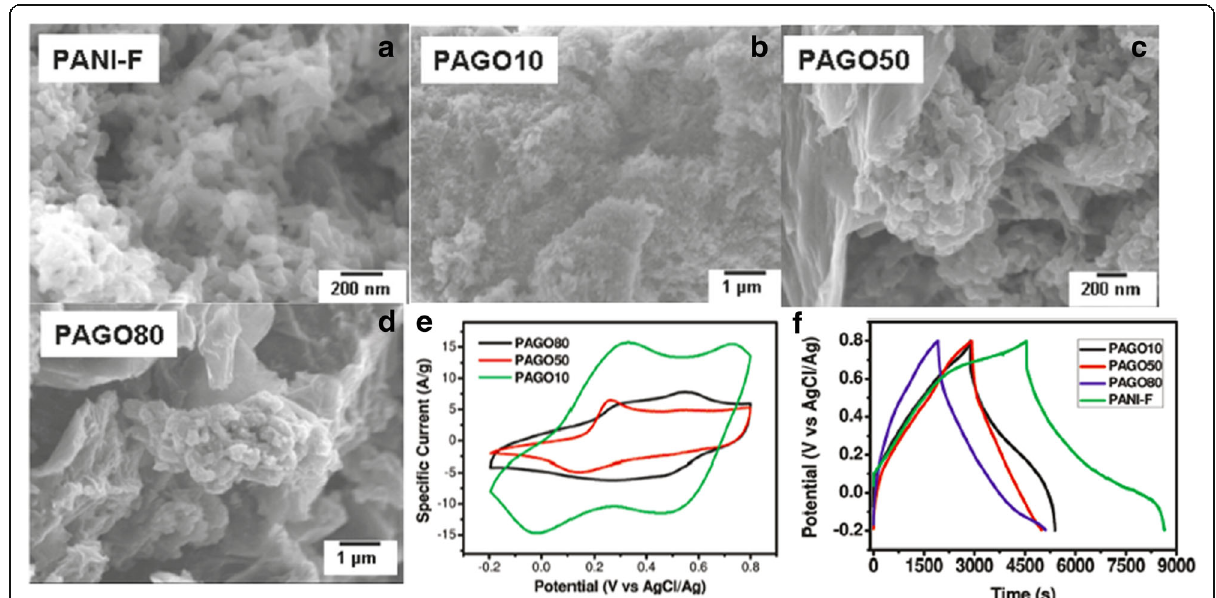
Fig. 5 a SEM of pure PANI fibers (PANI-F). b SEM of GO and PANI composites with GO weight percentage of 10% (PAGO 10). c SEM of GO and PANI composites with GO weight percentage of 50% (PAGO 50). d SEM of GO and PANI composites with GO weight percentage of 80% (PAGO 80). e Cyclic voltammograms recorded in 2 M H 2 SO 4 by using different composites coated with glassy carbon electrode as working electrode, a Pt sheet as counter electrode, and a AgCl/Ag electrode as reference electrode. The scan rate is 100 mV/s; f Charge/discharge cycling curves of different composite electrodes at a current density of 0.1 A/g. Reprinted with permission from [41]. Copyright 2010 American Chemical Society